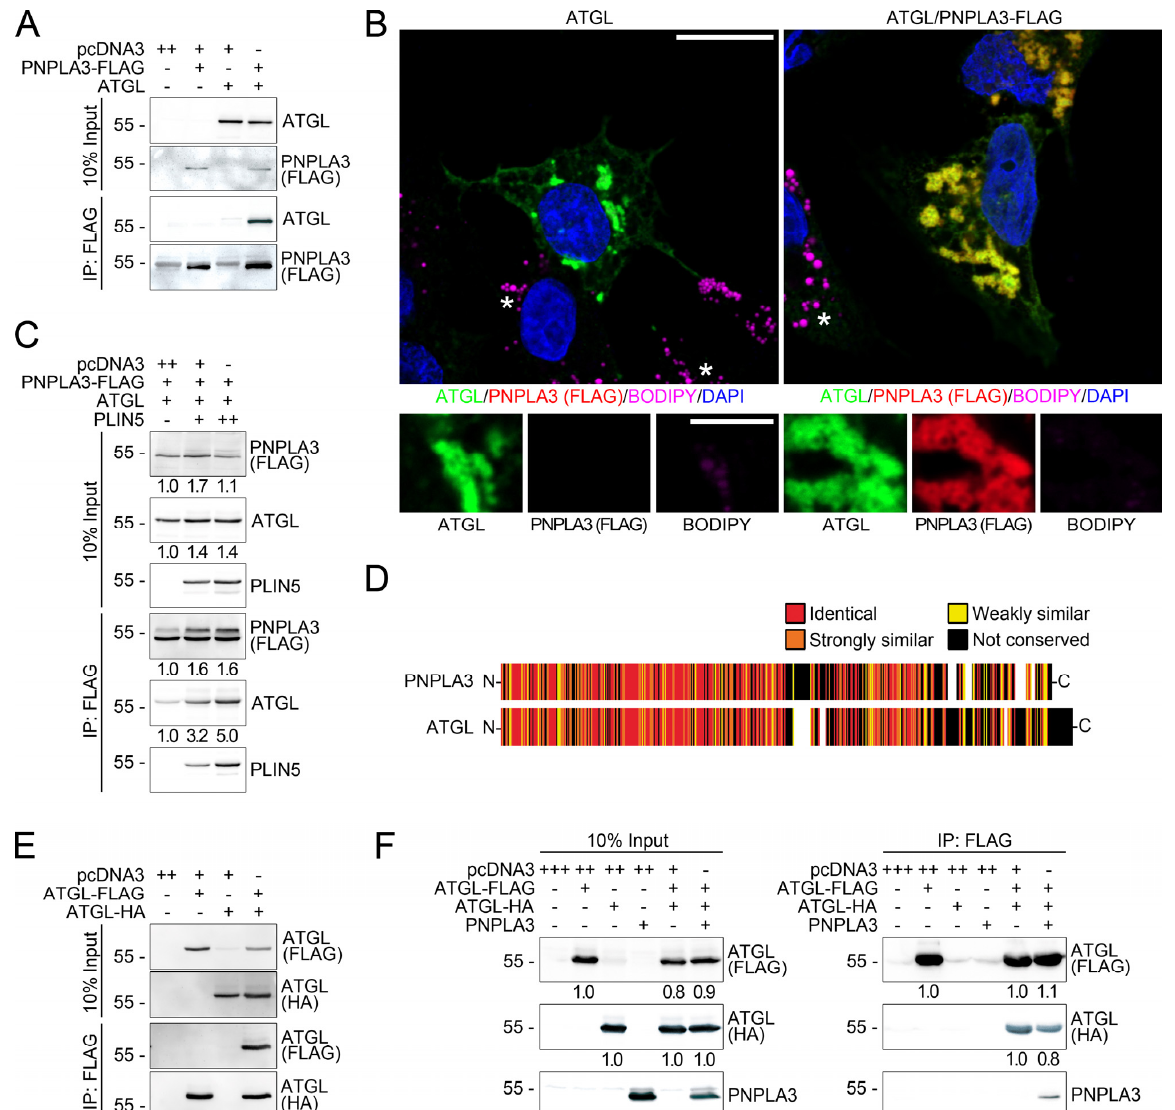
Figure 4. PNPLA3 interacts with ATGL in a perilipin 5-dependent manner. ( A ) Immunoblot analyses of ATGL and PNPLA3 in co-immunoprecipitates of FLAG-tagged PNPLA3 in HEK293T cells transfected with FLAG-tagged PNPLA3 alone and/or together with ATGL shows that PNPLA3 interacts with ATGL. ( B ) Immunofluorescence microscopy of HepG2-cells transfected with FLAG- tagged ATGL (green) alone or together with PNPLA3 (red). LDs: BODIPY, violet; nuclei: DAPI, blue. PNPLA3 and ATGL strongly colocalize at smaller sized LDs. Asterisks indicate non- transfected cells that exhibit LDs of detectable size. Scale bars: 15 µm, magnified images: 5 µm. ( C ) Immunoblot analysis of PNPLA3, ATGL and perilipin 5 (PLIN5) in co-immunoprecipitates of FLAG-tagged PNPLA3 in HEK293T cells transfected with FLAG-tagged PNPLA3, constant amounts of ATGL together with increasing amounts of perilipin 5 (PLIN5). The interaction of PNPLA3 with ATGL is dramatically increased by perilipin 5 in a dose-dependent manner. ( D ) Schematic representation of an alignment of PNPLA3 with ATGL shows a high degree of similarity. ( E ) Immunoblot analysis of ATGL (HA and FLAG) in co-immunoprecipitates of FLAG-tagged ATGL in HEK293T cells transfected with FLAG-tagged ATGL alone and together with HA-tagged ATGL shows that FLAG-tagged ATGL interacts with HA-tagged ATGL. ( F ) Immunoblot analysis of ATGL (HA and FLAG) and PNPLA3 in co-immunoprecipitates of FLAG-tagged ATGL in HEK293T cells transfected with FLAG-tagged ATGL alone and together with HA-tagged ATGL in the